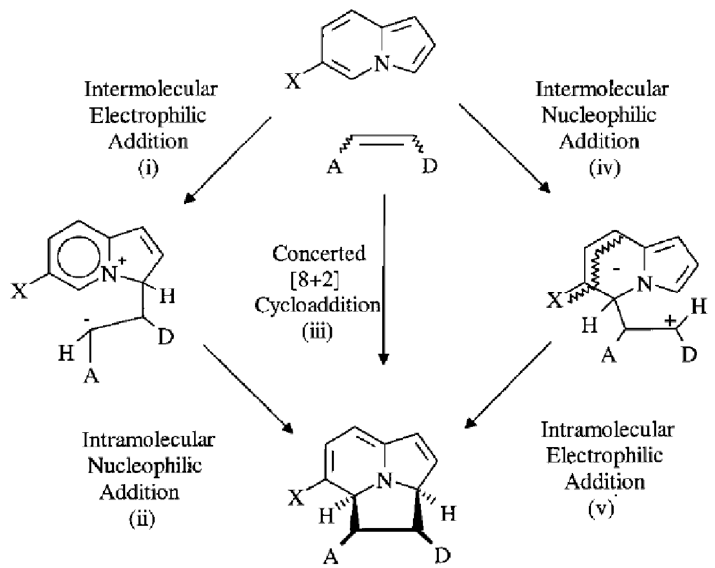
Table 23. Possible mechanisms of [8+2] cycloaddition depending on the nature of groups in alkene and indolizne as shown on Scheme